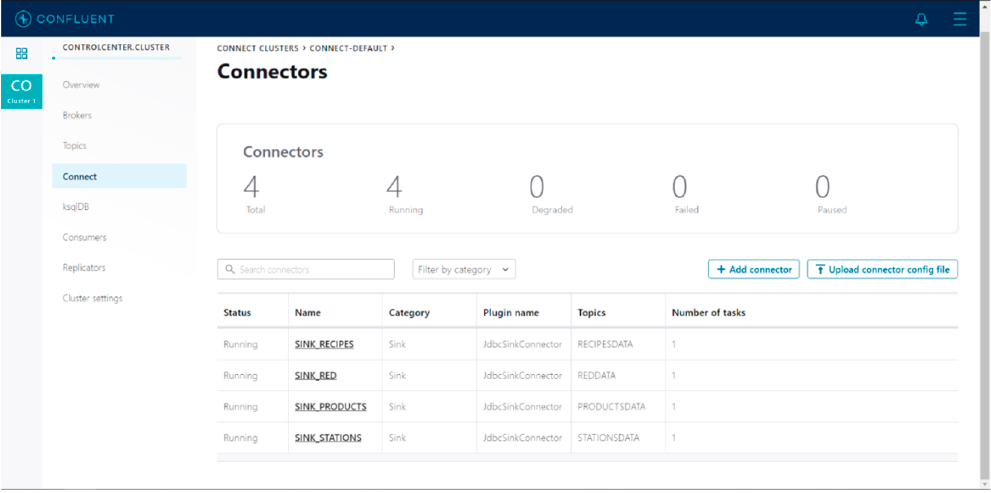
Figure 11. Connectors View.